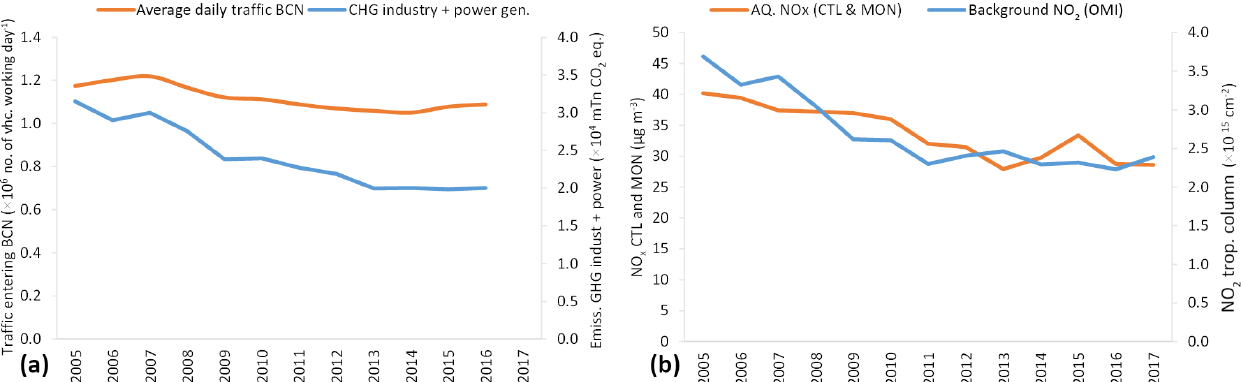
Figure 5. (a) Annual average traffic entering Barcelona during weekdays (weekends not considered) during 2005–2016 versus GHG emis- sions (attributed to industry and power generation sectors) in Catalonia during 2005–2016. (b) Annual NO x measured at CTL (Ciutadella) and MON (Montcada) air quality monitoring sites versus annual OMI-NASA measured background NO 2 during 2005–2017.